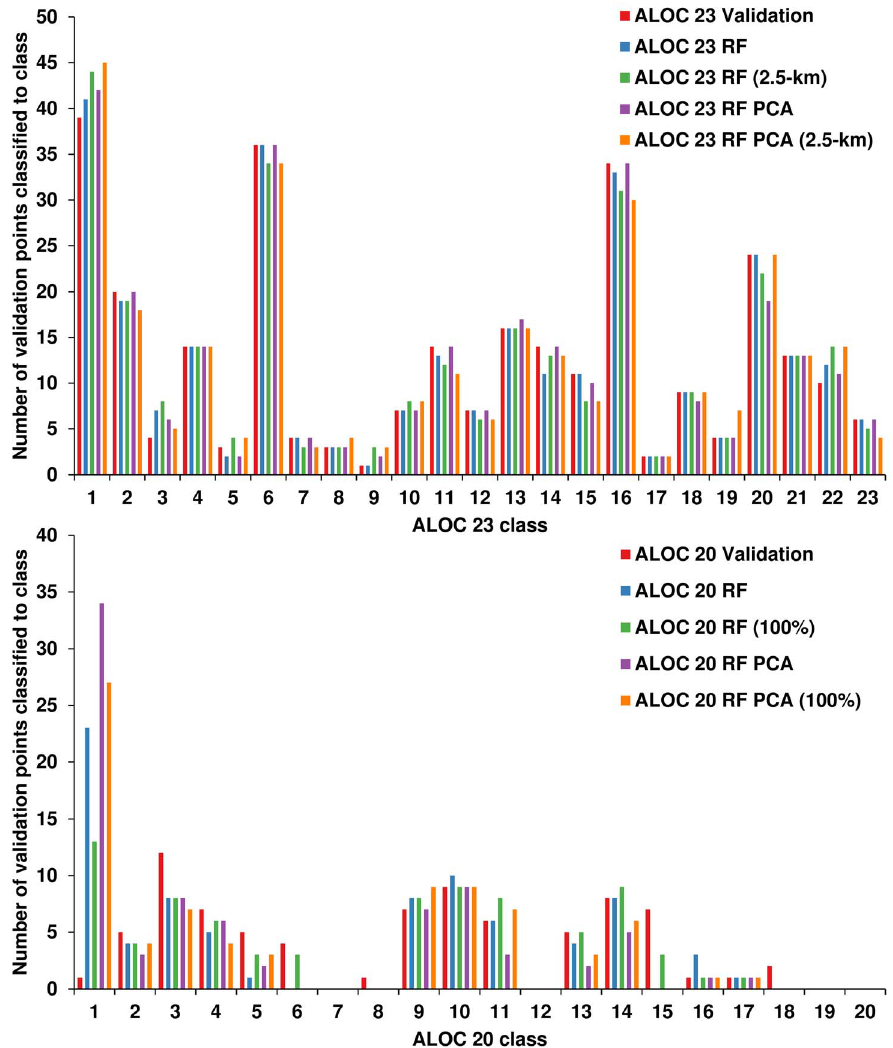
Figure 7. Class distributions from the final classified images. The 20% validation points were used to extract class information from the classified images. The resulting figure shows that the ALOC 23 classifications were much better at maintaining the class distribution of the validation dataset (shown above in red) than the ALOC 20 classifications.